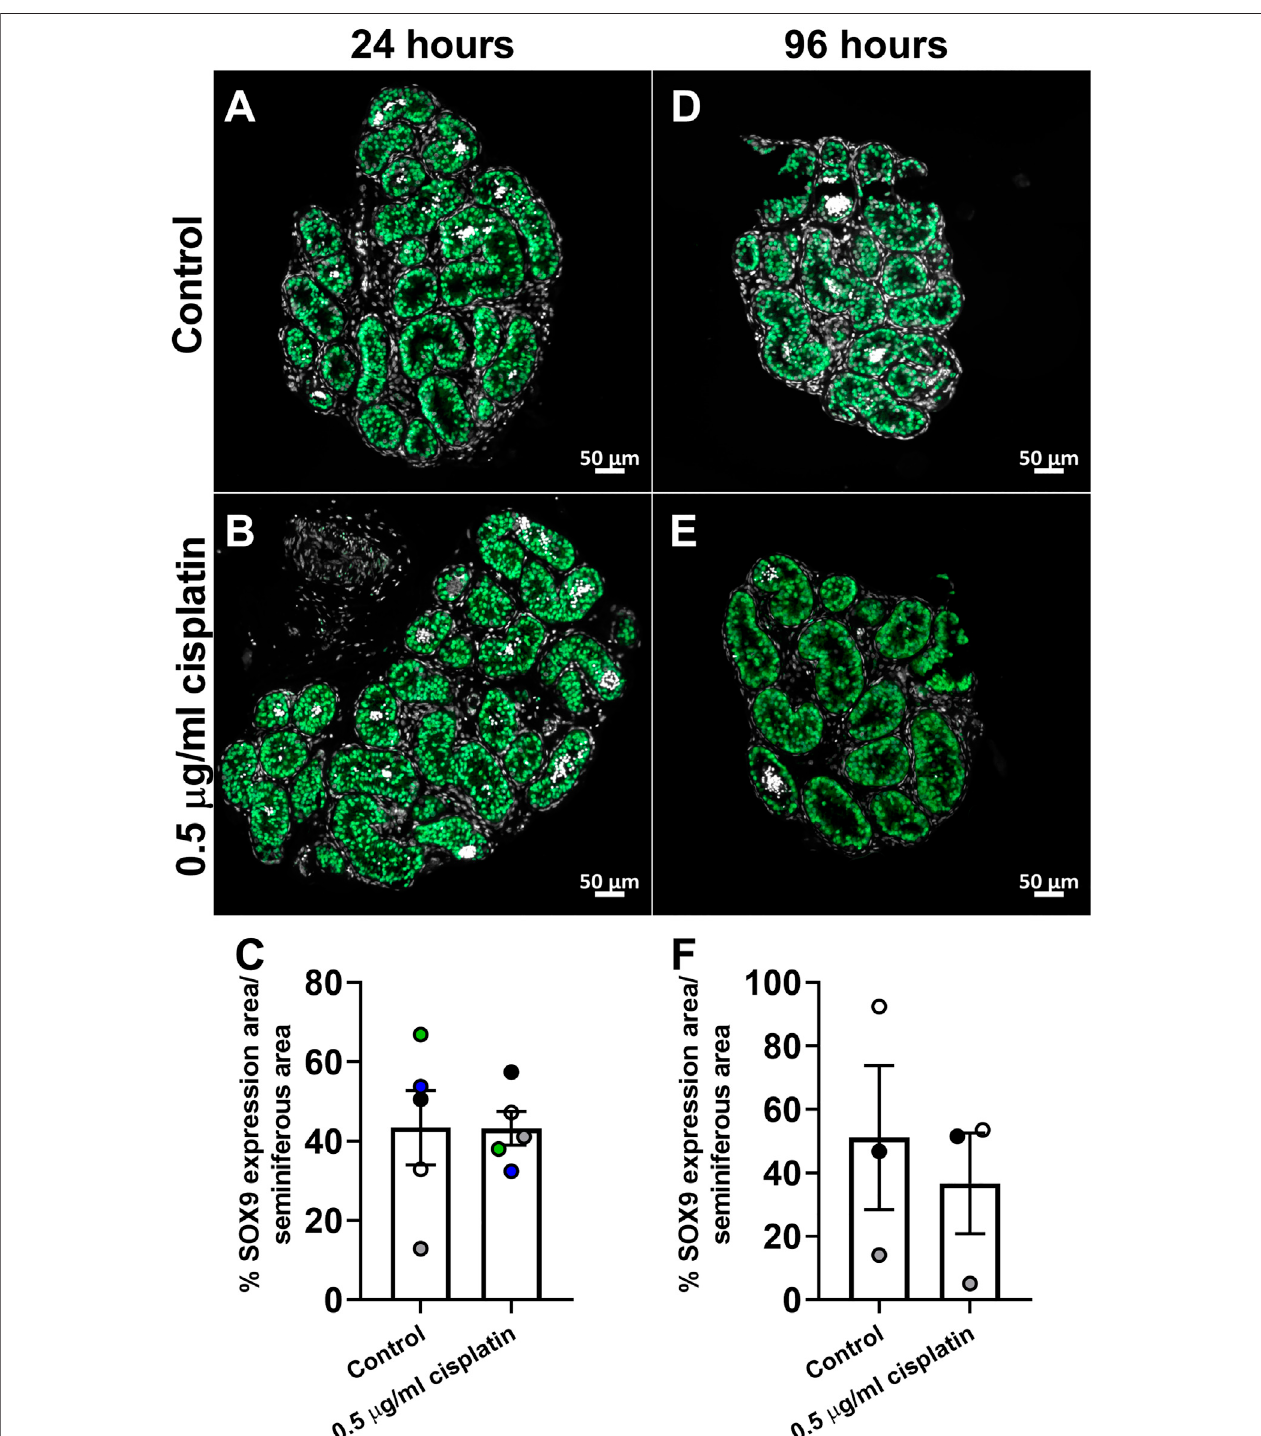
FIGURE 6 | Effects of exposure to cisplatin on Sertoli cells in human pre-pubertal testicular tissues. SOX9 (green) protein expression in the human pre-pubertal testicular tissues exposed to vehicle control (A,D) or 0.5 μ g/ml cisplatin (B,E) for 24 h and further cultured until 24 (A,B) and 96 (D,E) hrs post-exposure. Scale bars represent 50 μ m. Quanti fi cation of percentage of tubular area expressing SOX9 (C) in human pre-pubertal testicular tissues at 24 h (C) and 96 h (F) post-exposure. No effect was observed on the percentage of tubular area expressing SOX9 in human pre-pubertal testicular tissues in tissues exposed to cisplatin compared to control. Data analysed using two-way ANOVA. Values shown are means ± SEM and each set of coloured data points (white and black — 1 year, green — 8 years, blue — 11 years and grey — 12 years) represents an individual patient ( n = 3 – 5).